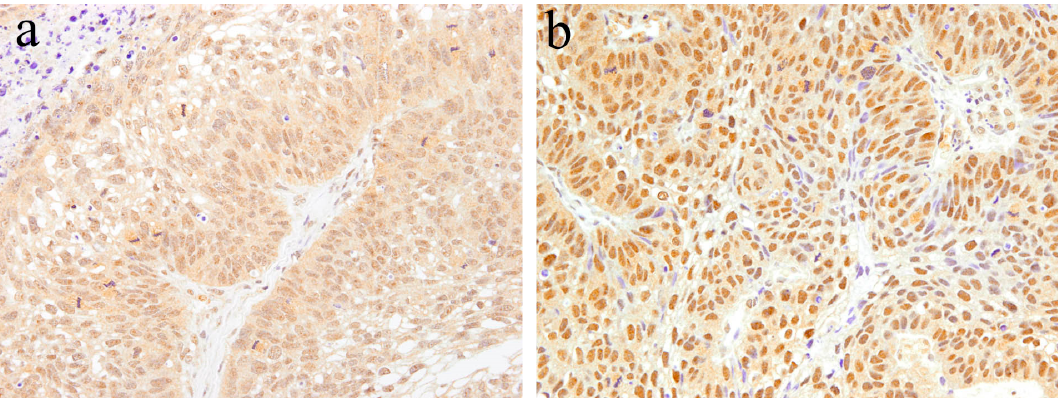
Figure 7. Immunohistochemical features of Notch1 expression in ameloblastic carcinoma. ( a ) Notch expression tends to be strong in the peripheral columnar cells. Positive reactions are mainly found in the cytoplasm. Magnification × 100. ( b ) Atypical cells, such as basaloid epithelium or spindle epithelial cells, show strong Notch expression. Positive reactions are mainly found in the nuclei. Magnification × 100. Anti-Notch-1 intracellular domain antibody, Abcam, ab83232, 1:100.